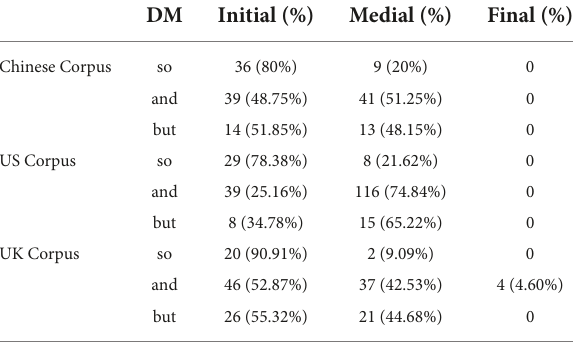
TABLE 4 The frequency of DM position in the three corpora.